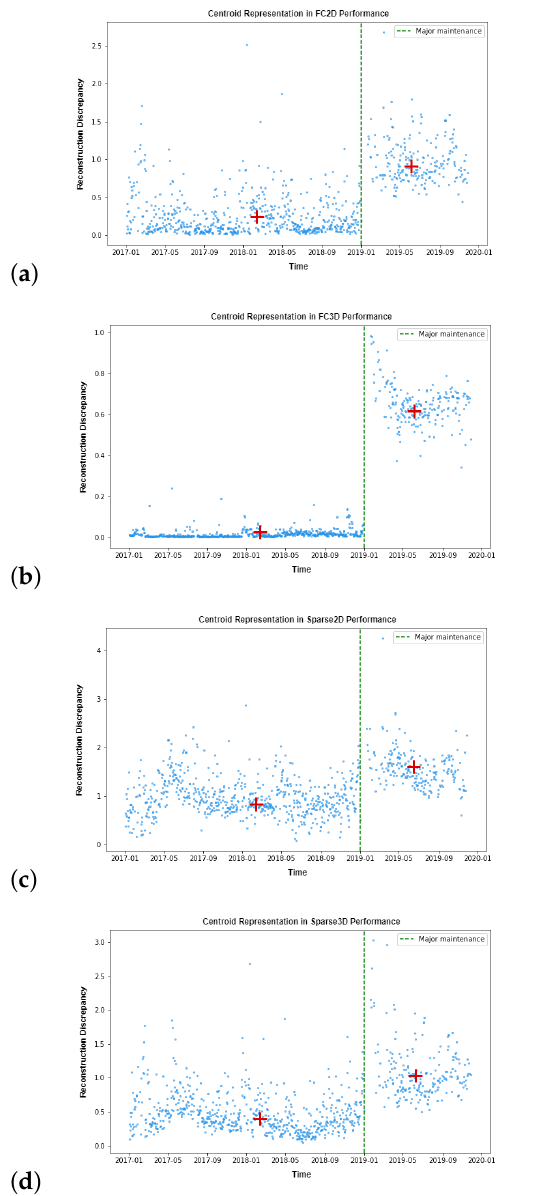
Figure 5. Major maintenance together with new reconstruction discrepancy in combination with the two AE structures and the two latent space dimensions: ( a ) FC2D model performance; ( b ) FC3D model performance; ( c ) Sparse2D model performance; ( d ) Sparse3D model